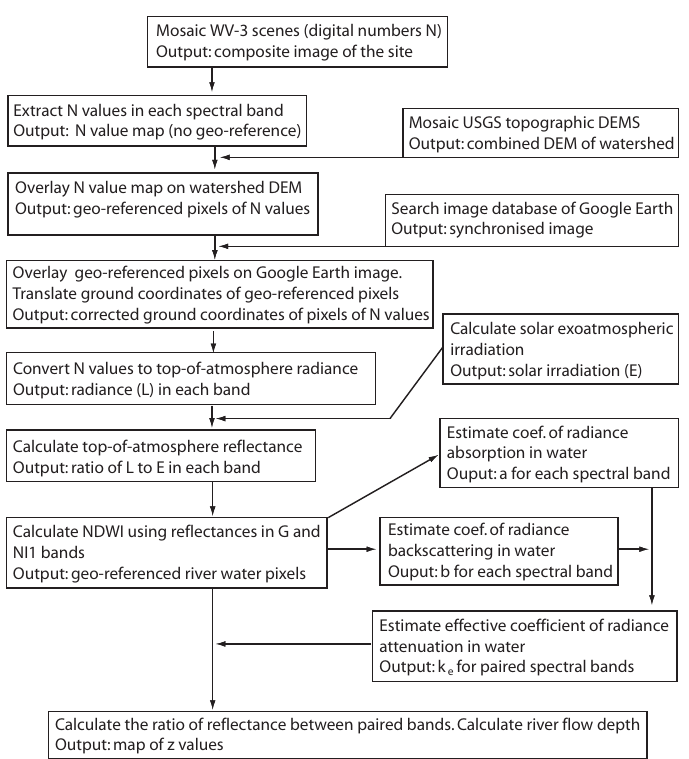
Figure 6. Flow chart for calculations of flow